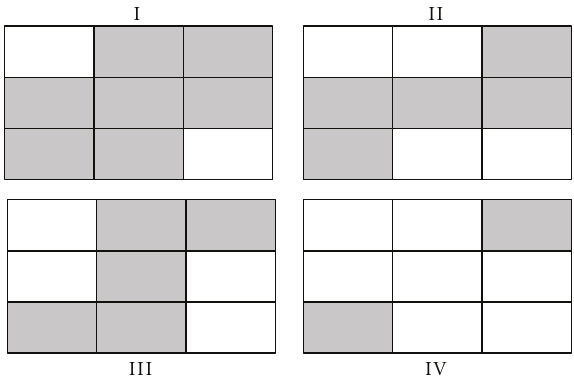
Figure 4: All four cases are depicted: (I) when (1 + g 1 11 ) / (1 + g 2 21 ) > (1 + g 1 21 ) / (1 + g 2 11 ) and (1 + g 1 22 ) / (1 + g 2 12 ) > (1 + g 1 12 ) / (1 + g 2 22 ), (II) when (1+ g 1 11 ) / (1+ g 2 21 ) < (1+ g 1 21 ) / (1+ g 2 11 ) and (1+ g 1 22 ) / (1+ g 2 12 ) > (1 + g 1 12 ) / (1 + g 2 22 ), (III) when (1 + g 1 11 ) / (1 + g 2 21 ) > (1 + g 1 21 ) / (1 + g 2 11 ) and (1 + g 1 22 ) / (1 + g 2 12 ) < (1 + g 1 12 ) / (1 + g 2 22 ), and finally when (IV) (1 + g 1 11 ) / (1 + g 2 21 ) < (1 + g 1 21 ) / (1 + g 2 11 ) and (1 + g 1 22 ) / (1 + g 2 12 ) < (1 + g 1 12 ) / (1 + g 2 22